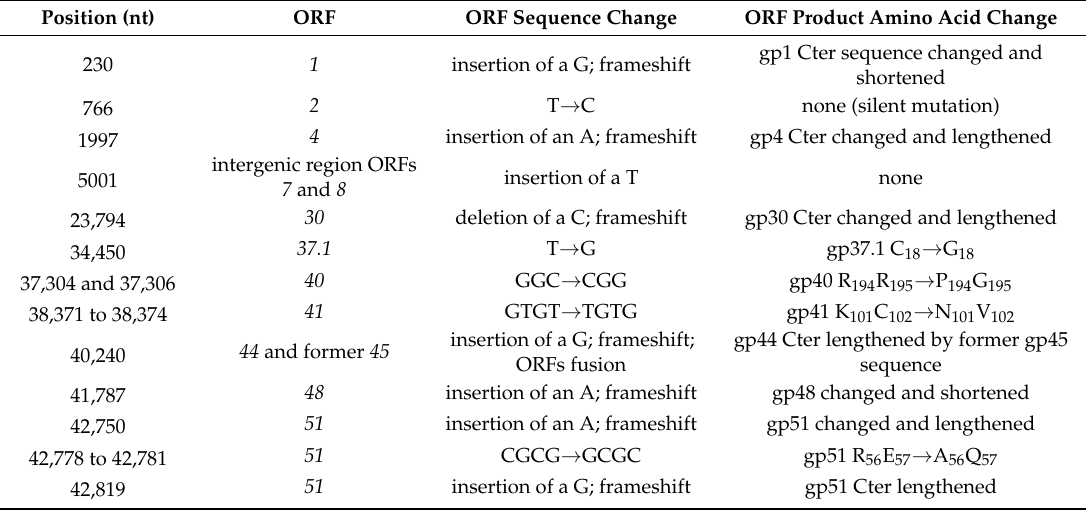
Table 1. Revision of the SPP1 sequence. Changes in the GenBank X97918.2 sequence relative to the GenBank X97918.3 revised version are listed. The position coordinates presented are the ones found in the GenBank X97918.3 sequence. The ORF concerned, the nucleotide sequence change(s), and the effect(s) on the gene product amino acid sequence are